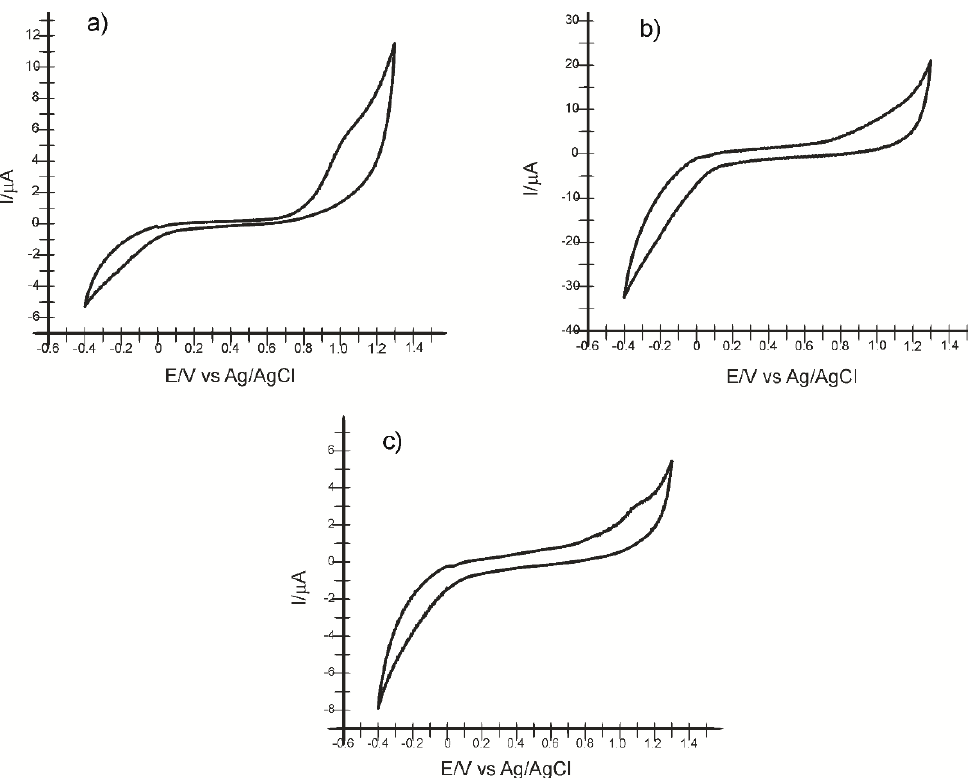
Figure 12. Cyclic voltammograms of the CNF-CoPc-Lac/SPE biosensor immersed in solution of ( a ) Spirulin, ( b ) Ghindazin, ( c ) Tuiazin, at 0.1 V/s scan rate.